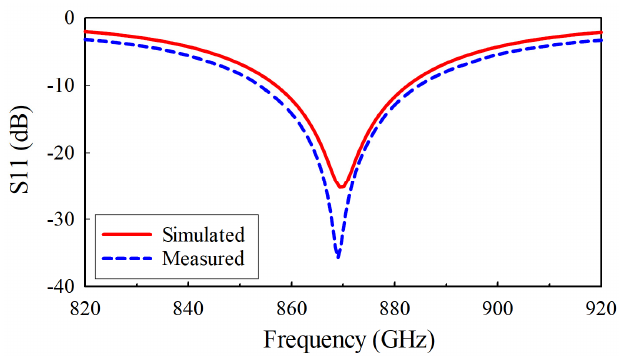
Figure 10. S 11 curve of LoRa aperture-fed antenna (868 MHz center frequency).